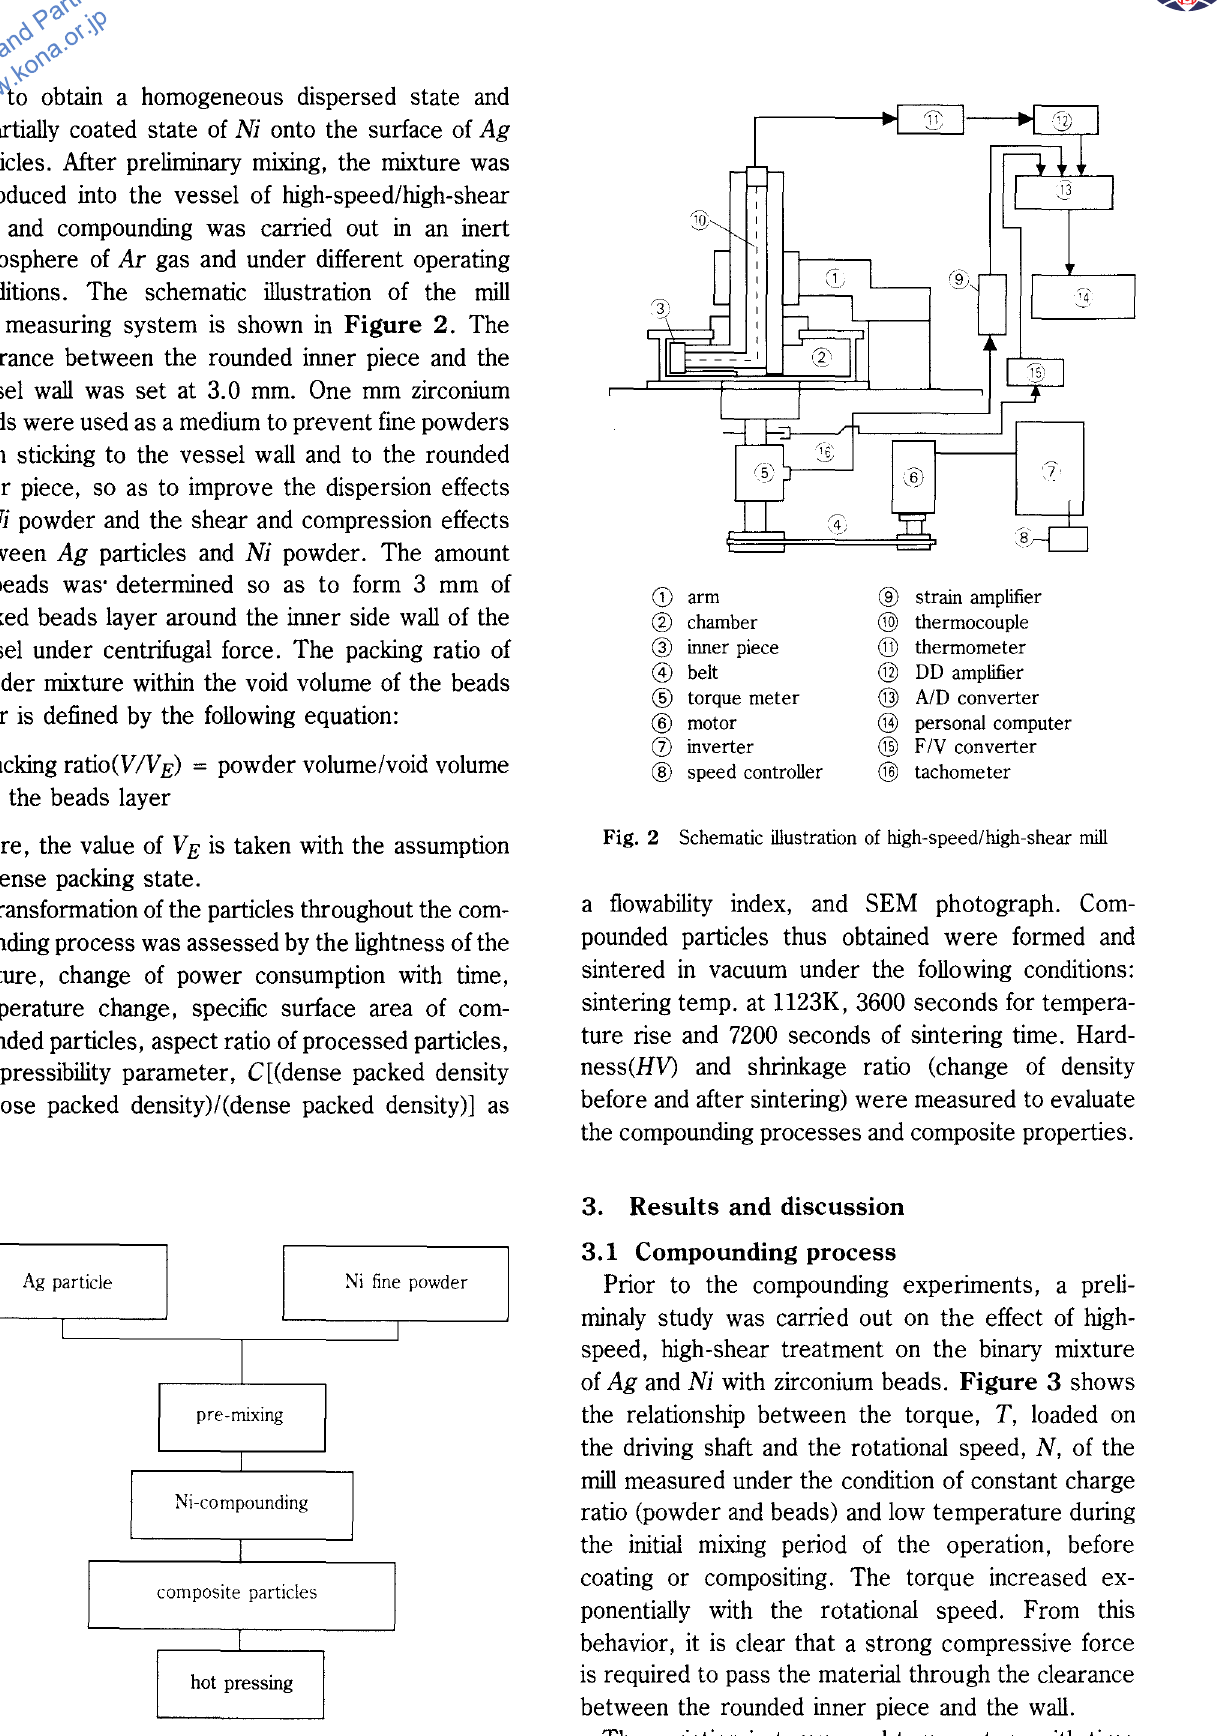
Fig. 1 Ag-Ni contact manufacturing process